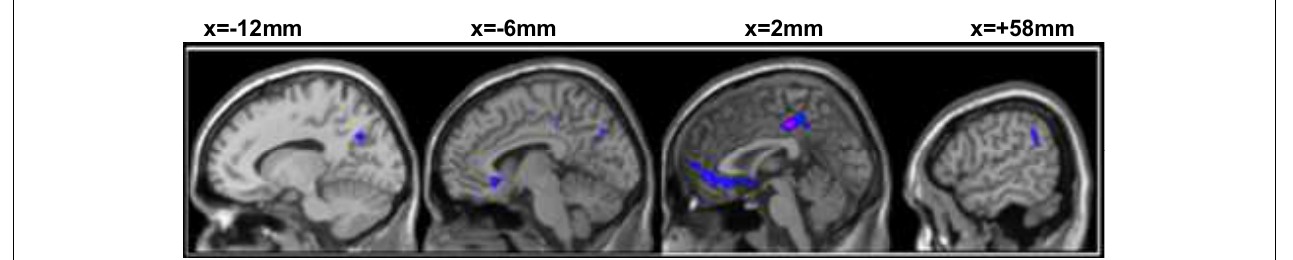
More specifically, and in line with Table 1 , perceptual matching on unfamiliar stimuli showed greater deactivations than saying “1,2,3” in pPCC (peak at − 2 − 72 38, z = 4.6) whereas the reverse was significant in pvMPFC (global peak at 6 16 − 10, z = 7.0). Last but not least, semantic matching on objects showed greater deactivations than semantic matching on words in RIPL (peak at 52 − 54 48, z = 5.3); for more details, see Table 1 of the main